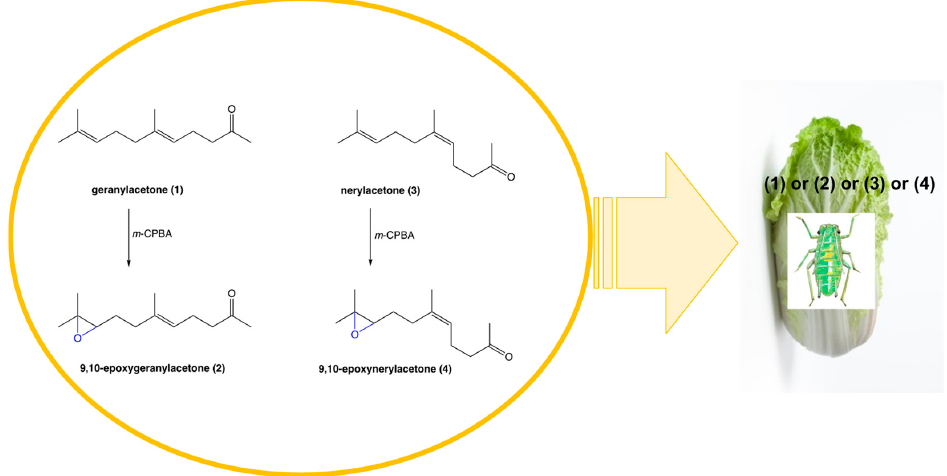
Figure 1. Chemical synthesis and application of 9,10 ‐ epoxygeranylacetone ( 2 ) and 9,10 ‐ epoxynerylacetone ( 4 ).